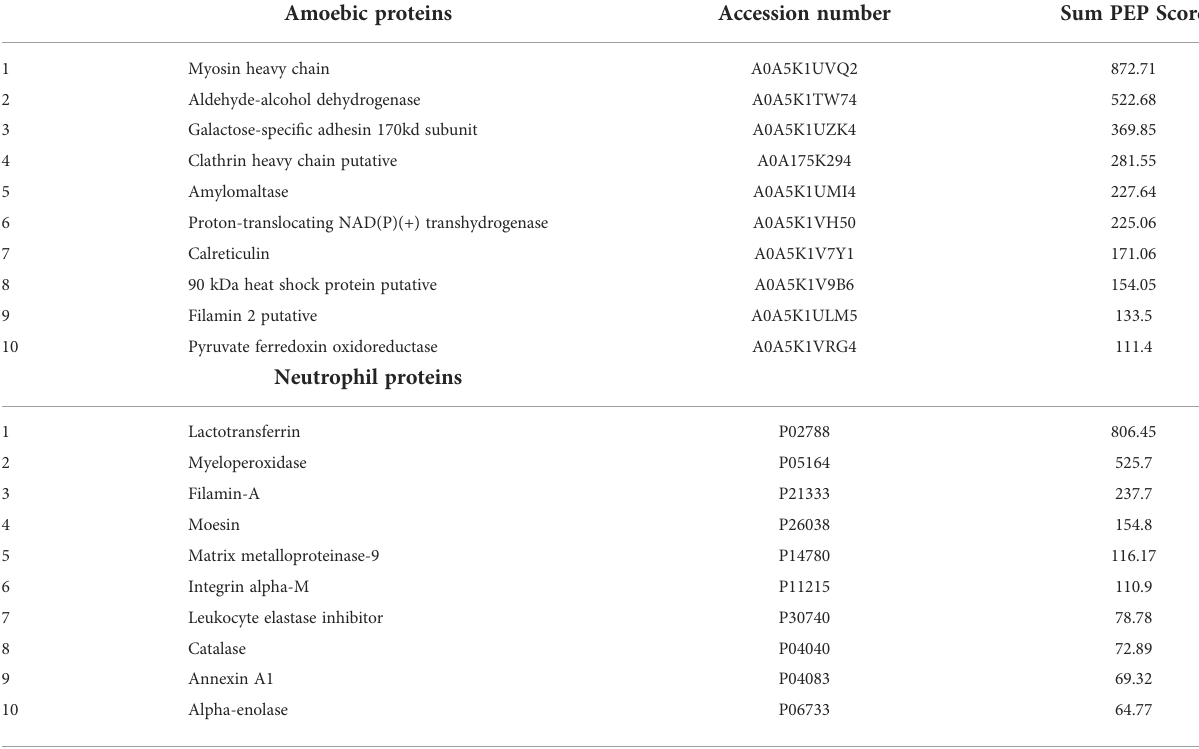
TABLE 2 Top 10 most abundant proteins found in EVs released by amoebic trophozoites and human